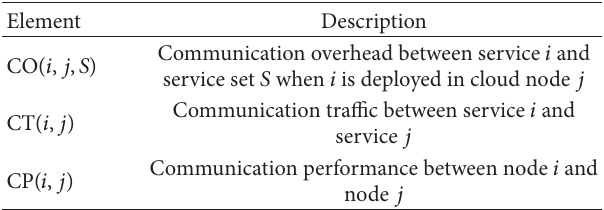
Table 1: Elements of the deployment